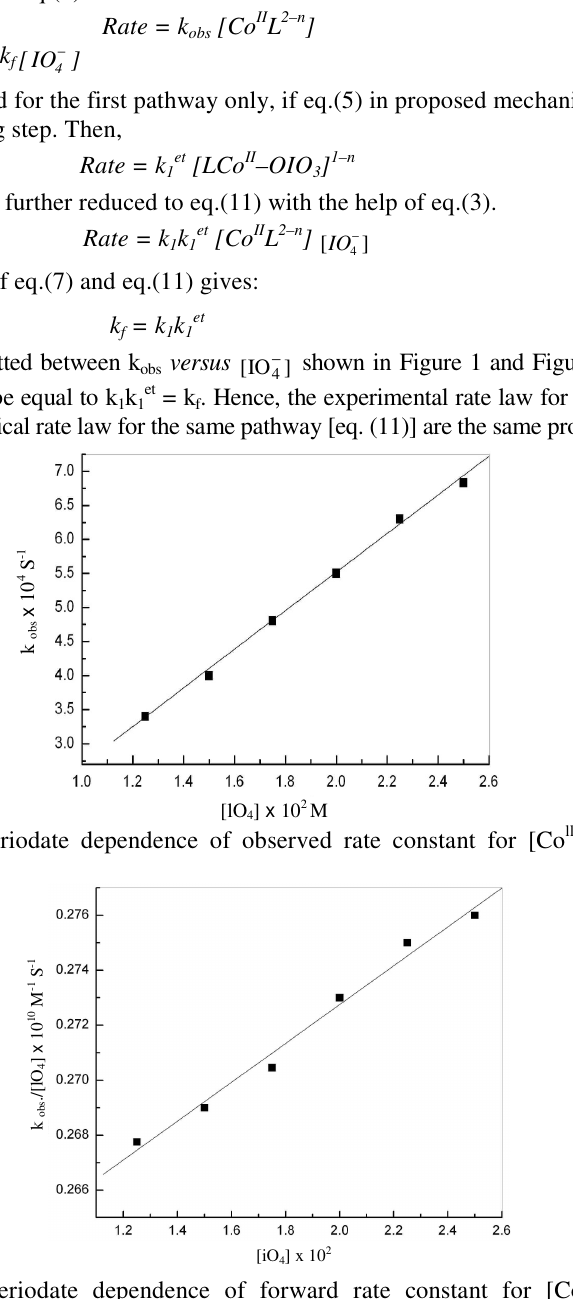
Figure 2. The periodate dependence of forward rate constant for [Co ll HDTA(H reaction